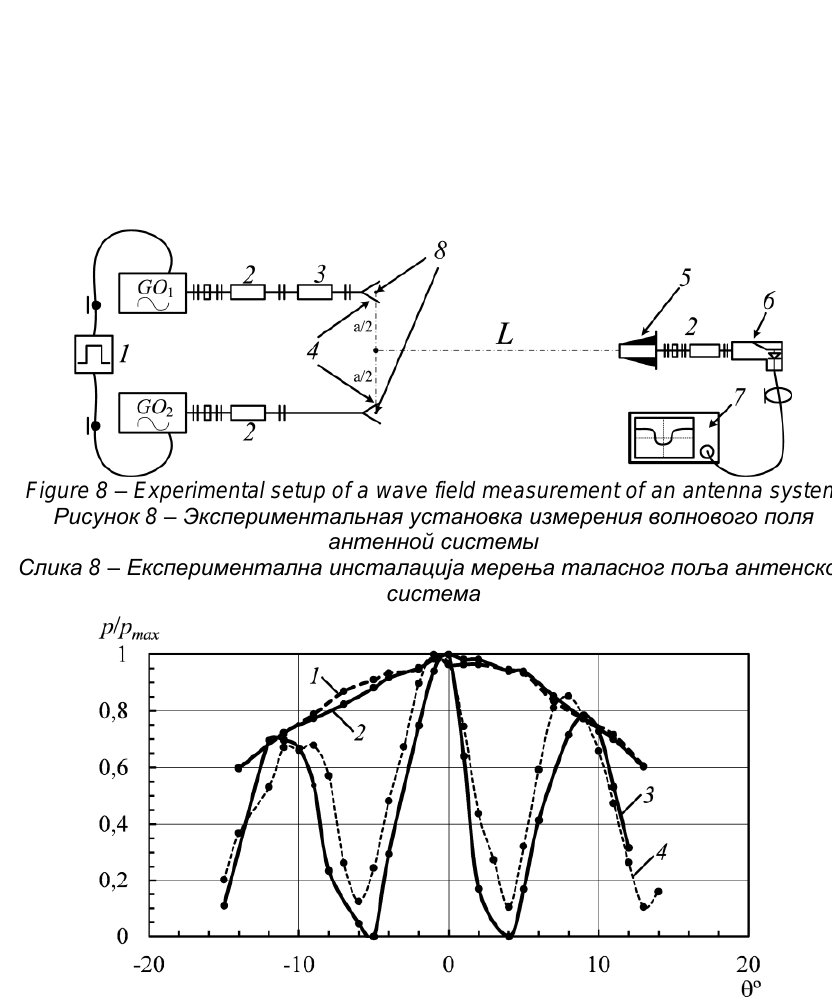
Figure 9 – Far-field measurement results: 1 , 2 – radiation pattern of each horn excited by an independent Gunn oscillator; 3 – microwave oscillations superposition of two horn antennas powered by a single standard oscillator with 500 us pulse duration; 4 – microwave oscillations superposition of two synchronized nanosecond Gunn